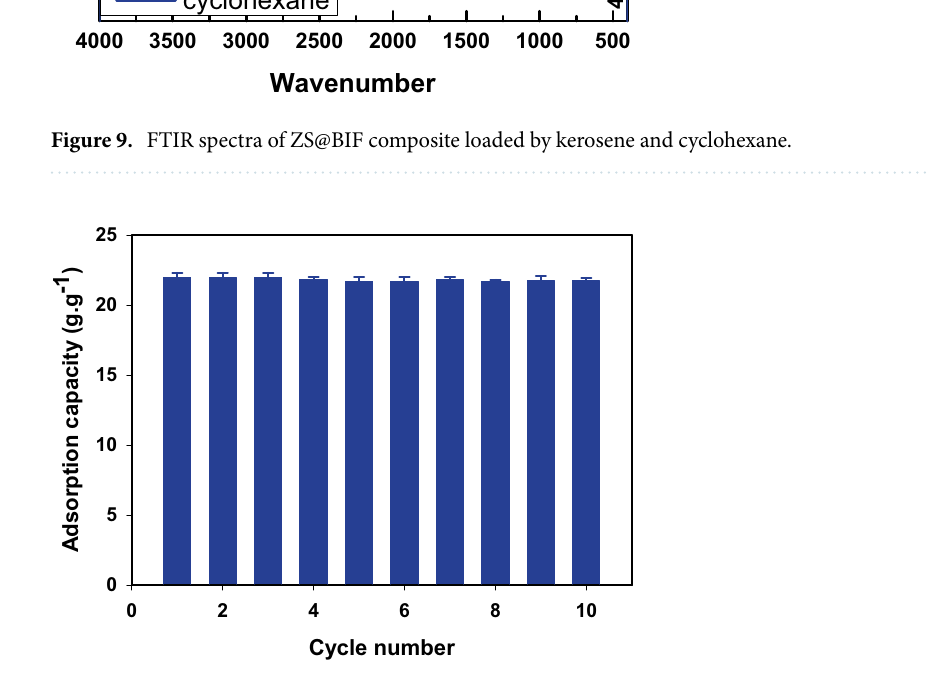
Figure 10. Adsorption performance of ZS@BIF composite for cyclohexane/water separation for 10